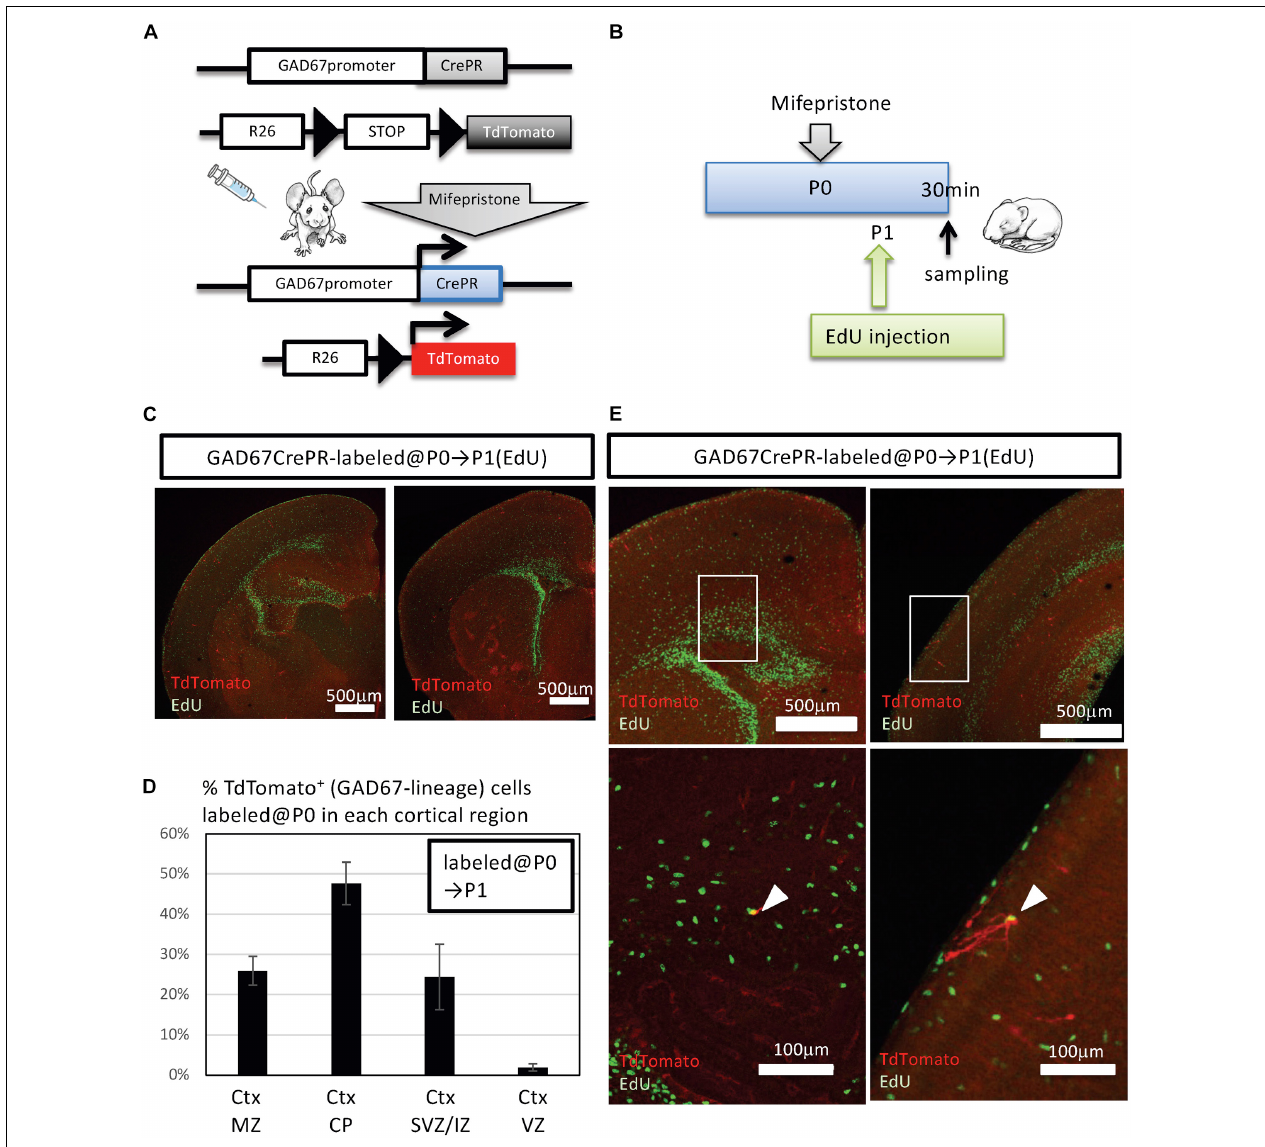
FIGURE 1 | Fate mapping analysis of postnatal GAD67 + intermediate progenitors of GABAergic inhibitory neurons (IPGNs) using GAD67-CrePR mouse. (A) Strategy for labeling GAD67-lineage cells by mifepristone-dependent recombination. Cre recombinase is restricted to GAD67-expressing cells after mifepristone treatment. The Rosa26 (R26)-floxed-TdTomato (Ai9) allele expresses TdTomato following Cre-mediated recombination. (B) Experimental design for labeling GAD67-lineage cells at the perinatal stage. Mifepristone was injected i.p. into GAD67-CrePR;Ai9 mice at P0, and EdU was injected at P1. Mifepristone- and EdU-treated mice were analyzed 30 min after EdU injection. (C) Immunohistochemistry for TdTomato (red) expression and EdU (green) at P1. An anti-RFP antibody was utilized to enhance TdTomato fluorescence. (D) Percentages of TdTomato + GAD67-lineage cells labeled at P0 in each cortical layer. Ctx, cortex; MZ, marginal zone; CP, cortical plate; SVZ/IZ, subventricular zone/intermediate zone. Error bars represent SDs ( n = 3 brains). (E) Representative images of TdTomato + GAD67-lineage cells (red) with EdU (green) in perinatal subventricular zone/intermediate zone (left) and marginal zone (right). Lower images show higher magnification of regions outlined with white boxes. White arrowheads indicate the double-positive